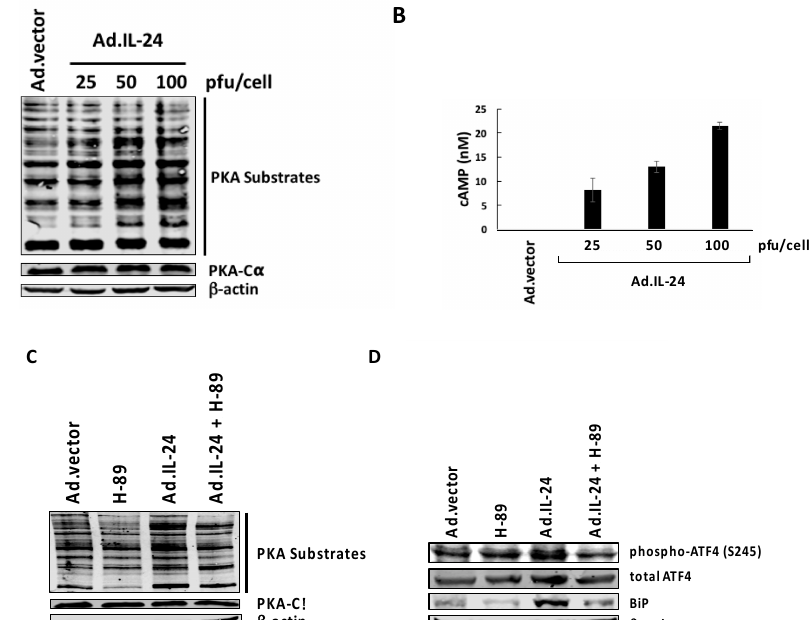
Figure 2. IL-24 activates protein kinase A (PKA) in a concentration-dependent manner. ( A ) MCF-7 cells were treated for 72 h with Ad.IL-24 (25, 50, and 100 pfu per cell) or Ad.vector (100 pfu per cell). Cells were collected, protein purified, and subjected to Western blot analysis to detect phospho-PKA substrates, PKA-C α subunits, and β -actin proteins. ( B ) MCF-7 cells were treated with Ad.vector (100 pfu/cell) or Ad.IL-24 (25, 50, and 100 pfu per cell) and then assayed for the production of cAMP after 20 h of treatment. Numbers represent mean cyclic adenosine monophosphate (cAMP) (nM) concentration after normalization to control. An average of three independent experiments is shown ± SE ( n = 9). ( C , D ) MCF-7 cells were treated for 72 h with Ad.vector (control) or Ad.IL-24 at 100 pfu/cell, and either untreated or treated with 10 µ M H-89 for 72 h. Cells were collected, protein purified, and subjected to Western blot analysis to detect phospho-PKA substrates, PKA-C α subunit, phospho-ATF4, total ATF4, and β -actin.